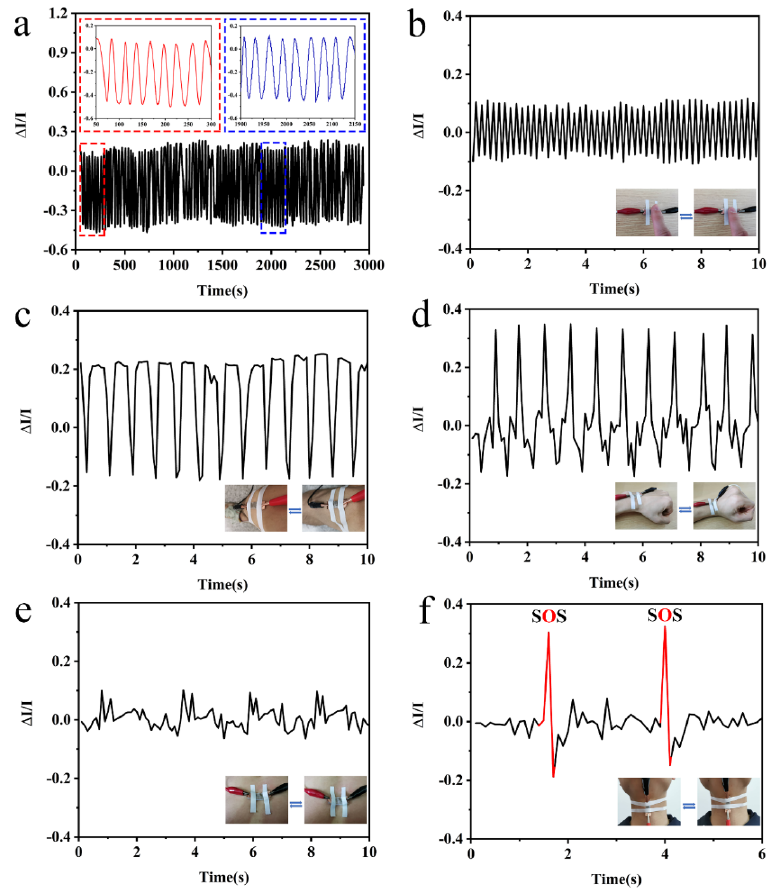
Figure 9. ( a ) Durability and stability testing results of the pressure sensor; ( b – f ) changes of sensing signals when the pressure sensor was attached to the human body caused by mechanical stimuli of ( b ) pressing of a finger, bending of the ( c ) knee, ( d ) wrist, ( e ) abdomen and ( f ) throat.